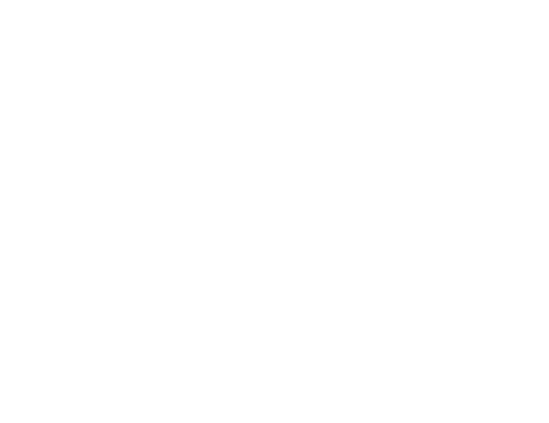
Figure 5. Group mean and individual performance for percentage body fat (%) before and after in recreational football for health intervention group and matched controls.